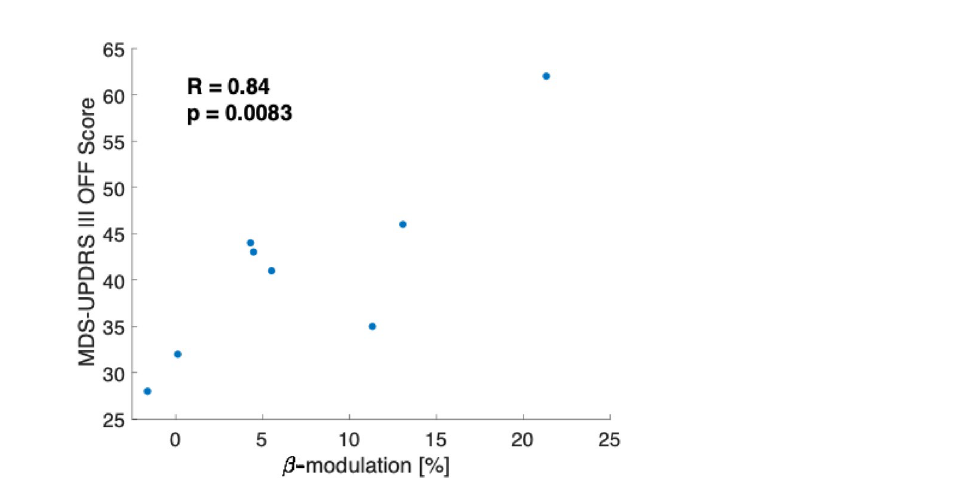
Figure 3. Relationship between disease burden and beta-modulatory capacity. We correlated the MDS-UPDRS III OFF score with the beta-modulatory capacity of each patient ( n = 8) and found a significant relationship ( p = 0.0083) with a positive Pearson correlation coefficient ( R =